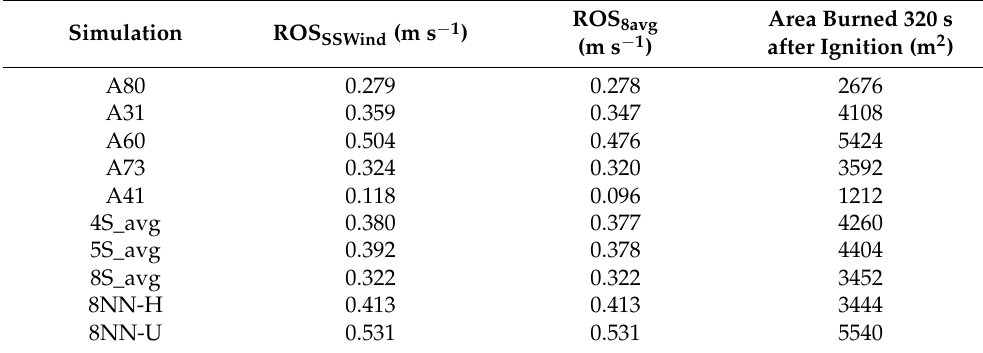
Table 3. Overview of simulation results, including fire spread metrics rate of spread and area burned for the 10